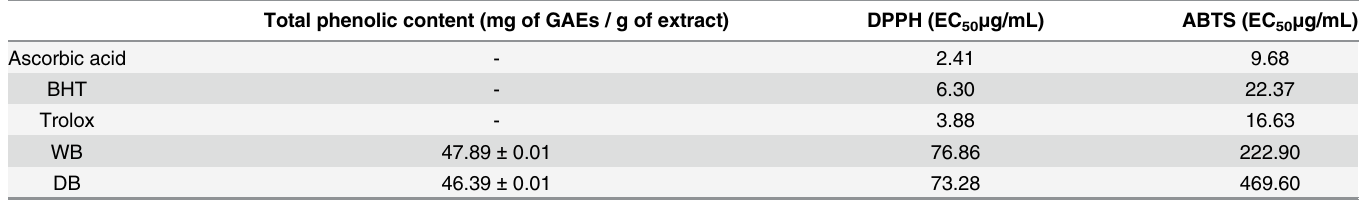
Table 3. Antioxidant activity and total phenolic content of WB and